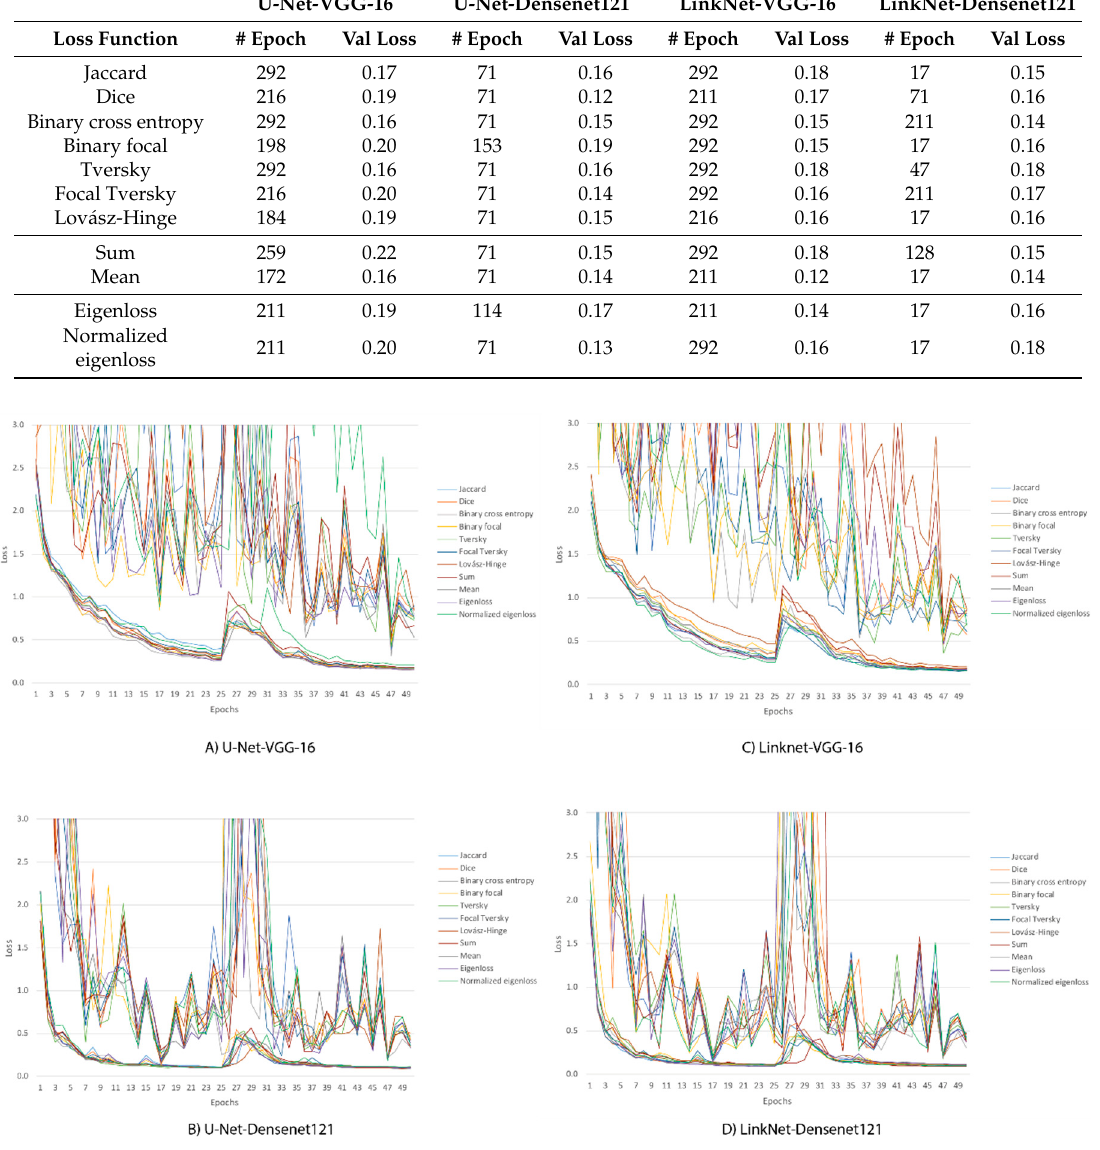
Figure 5. Initial convergence. ( A ) U-Net-VGG-16; ( B ) U-Net-Densenet121; ( C ) LinkNet-VGG-16; ( D ) LinkNet-Densenet121. Dark colors correspond to the training loss, while light colors correspond to the validation loss.